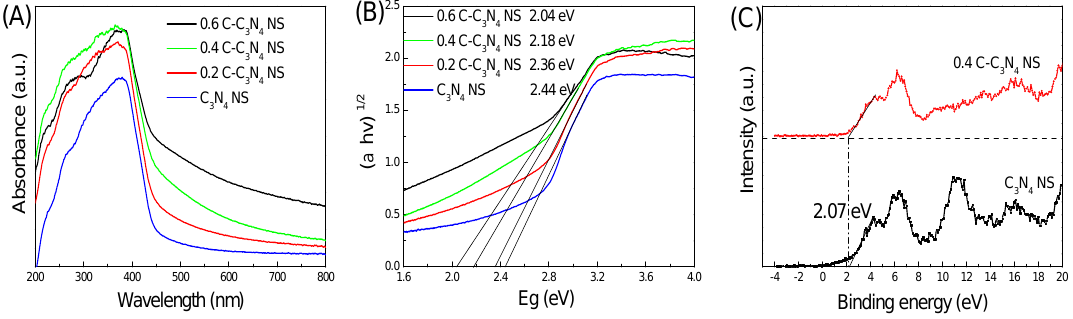
Figure 8. ( A ) UV–Vis diffuse reflection and ( B ) the estimated band gaps of series of samples. ( C ) VB ‐ XPS spectra for C 3 N 4 NS and 0.4 C ‐ C 3 N 4 NS samples.